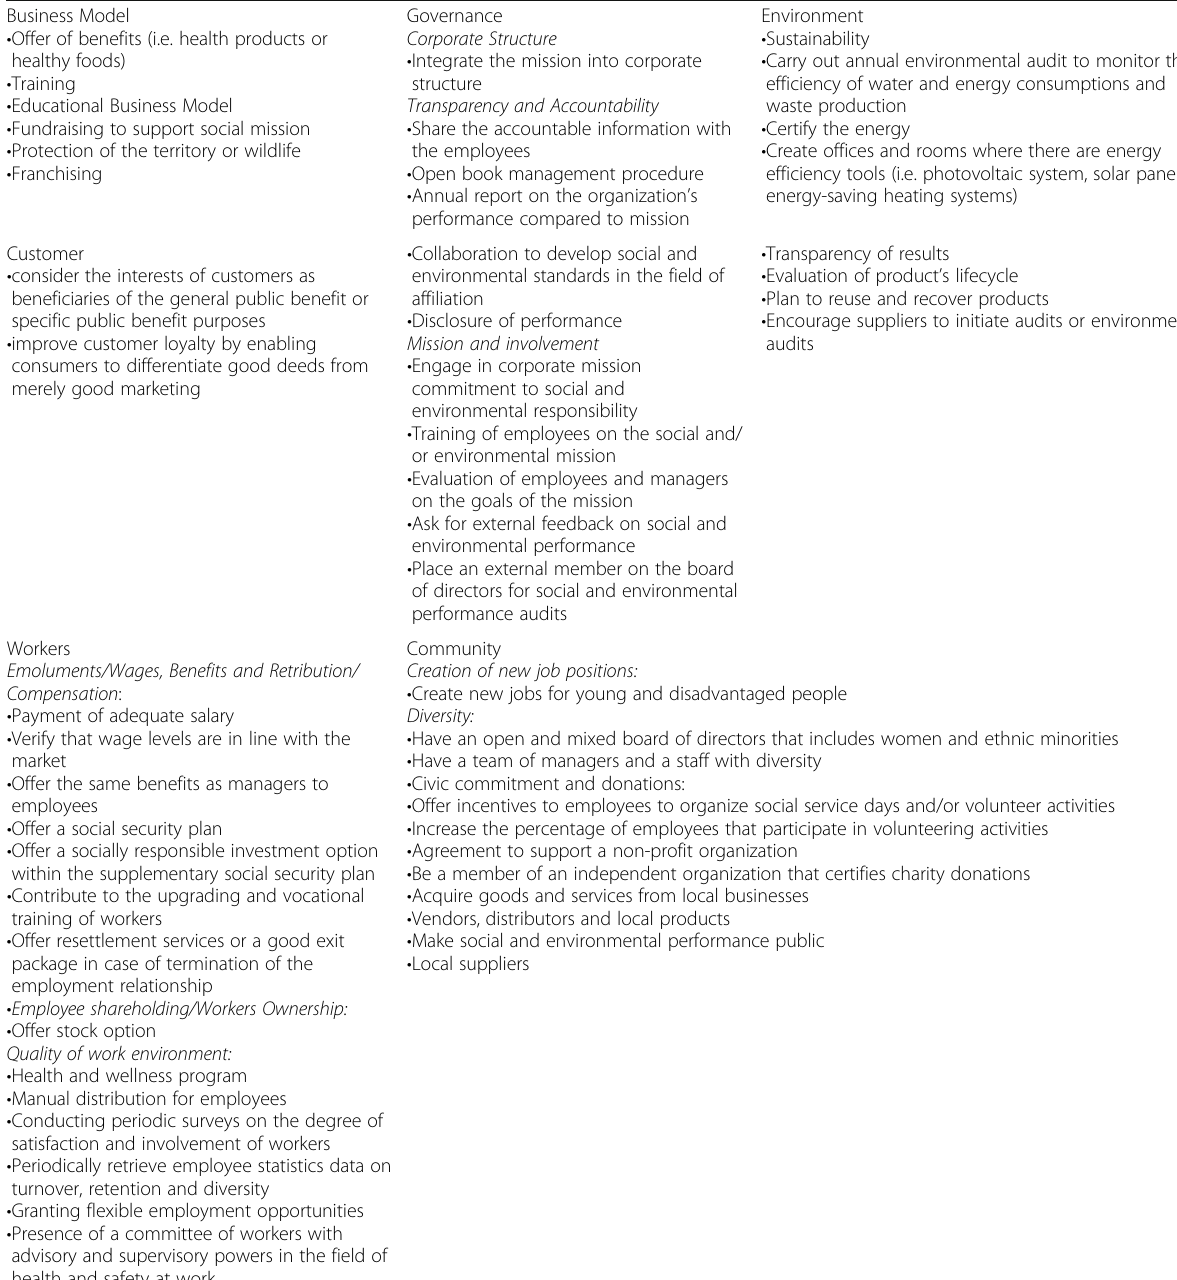
Table 1 Impact areas and